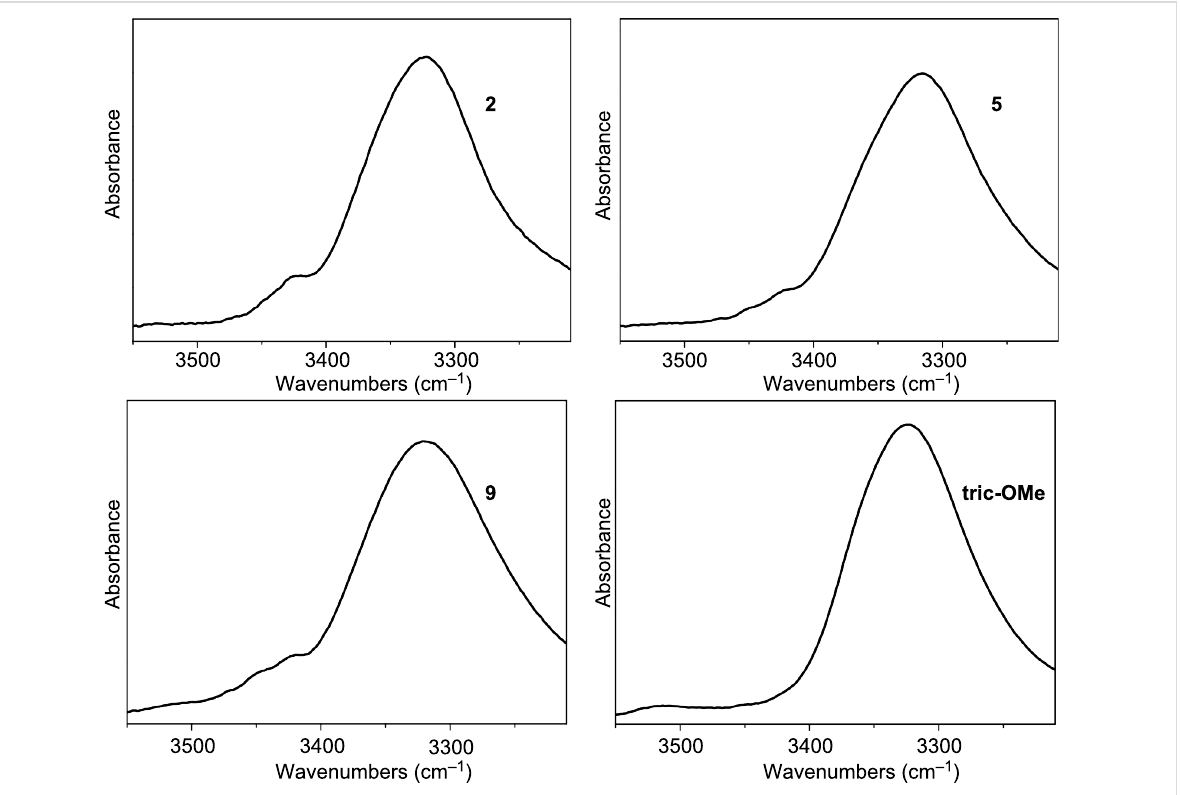
Figure 4: FT-IR absorption spectra (3550–3200 cm − 1 region) in CDCl 3 solution of [Leu 11 -OMe] trichogin GA IV ( tric-OMe ) and its ψ [CS-NH] 2 ( 2 ), ψ [CS-NH] 5 ( 5 ), and ψ [CS-NH] 9 ( 9 ) analogues. Peptide concentration: 1 mM.